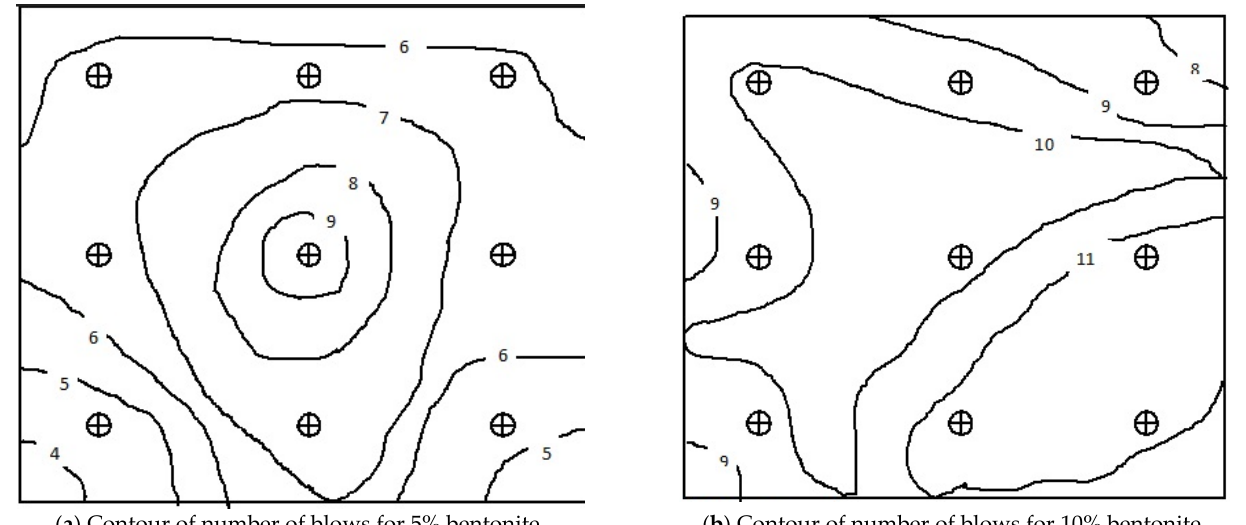
Figure 15. Site contour drawing for investigated points: ( a ) 5% bentonite; ( b ) 10% bentonite .